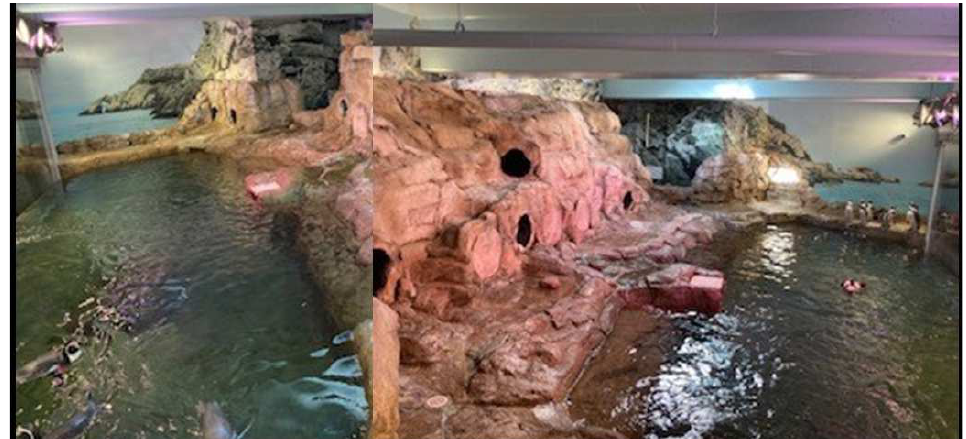
Figure 1. Penguin exhibit “map” for noting penguin location in Zoo Monitor. The shape of the exhibit necessitated using 2 photos and combining them. We adjusted for the angle discrepancy in calculations.